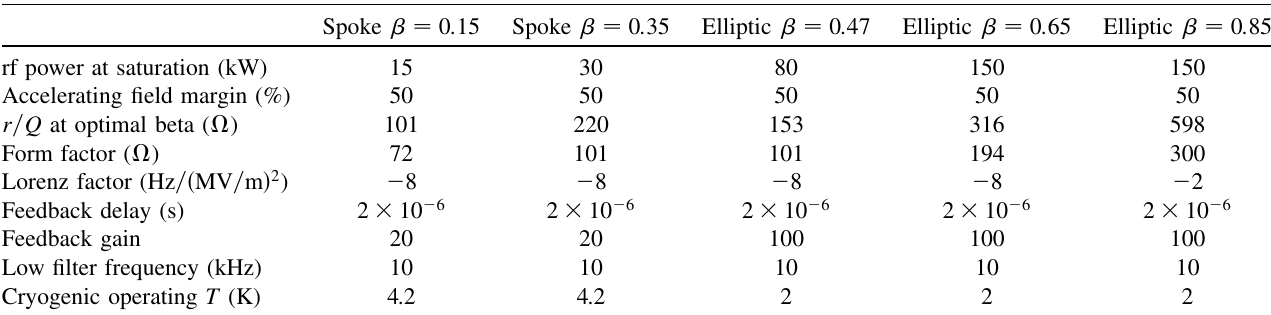
TABLE II. Cavity and rf loop characteristics used for XT-ADS linac transient calculations.